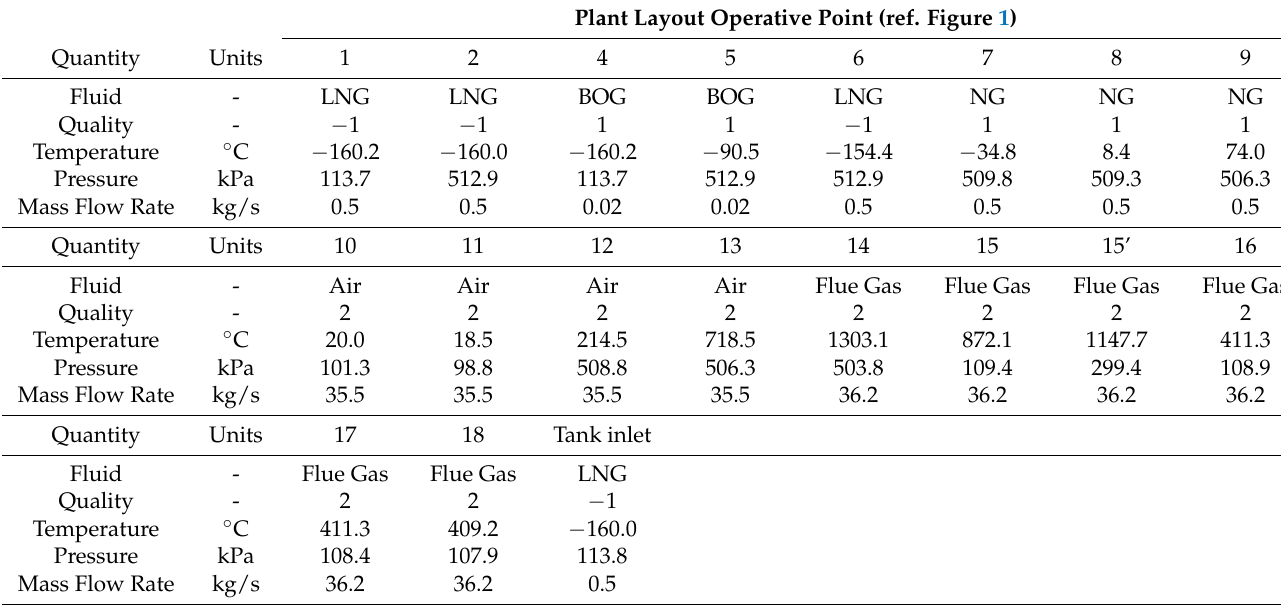
Table 1. Stationary Simulation Variables Values. Plant Layout Operative Point (ref. Figure